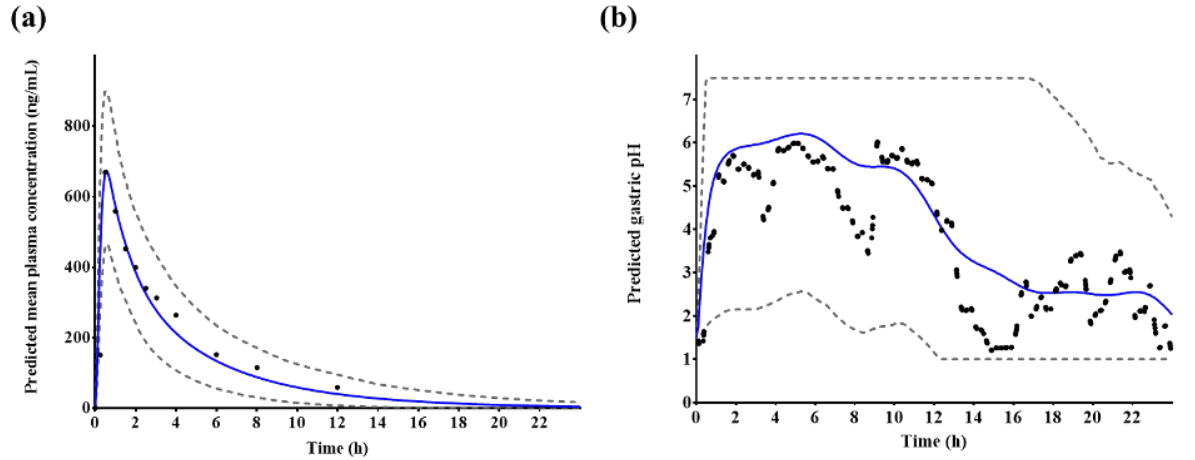
Figure 5. Predicted ( a ) plasma tegoprazan concentration and ( b ) gastric acid pH – time profiles after a single administrations of 50 mg tegoprazan. Blue solid lines represent the predicted mean values, gray dotted lines represent the predicted 5th and 95th percentile, and black dots represent the observed plasma tegoprazan concentration or gastric acid pH profiles, respectively.